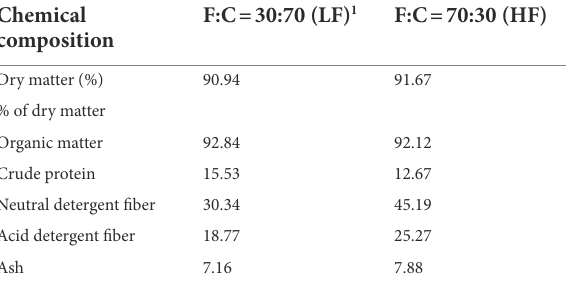
TABLE 1 Chemical composition of the experimental